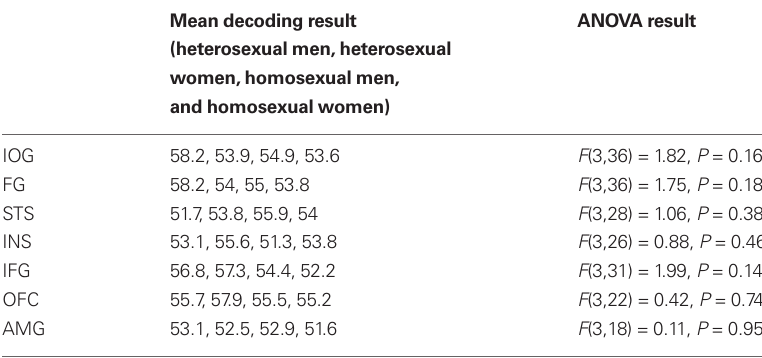
Table A1 | Complete table of statistical values for ANOVA results between subgroups of different gender and sexual orientation in the participant population.